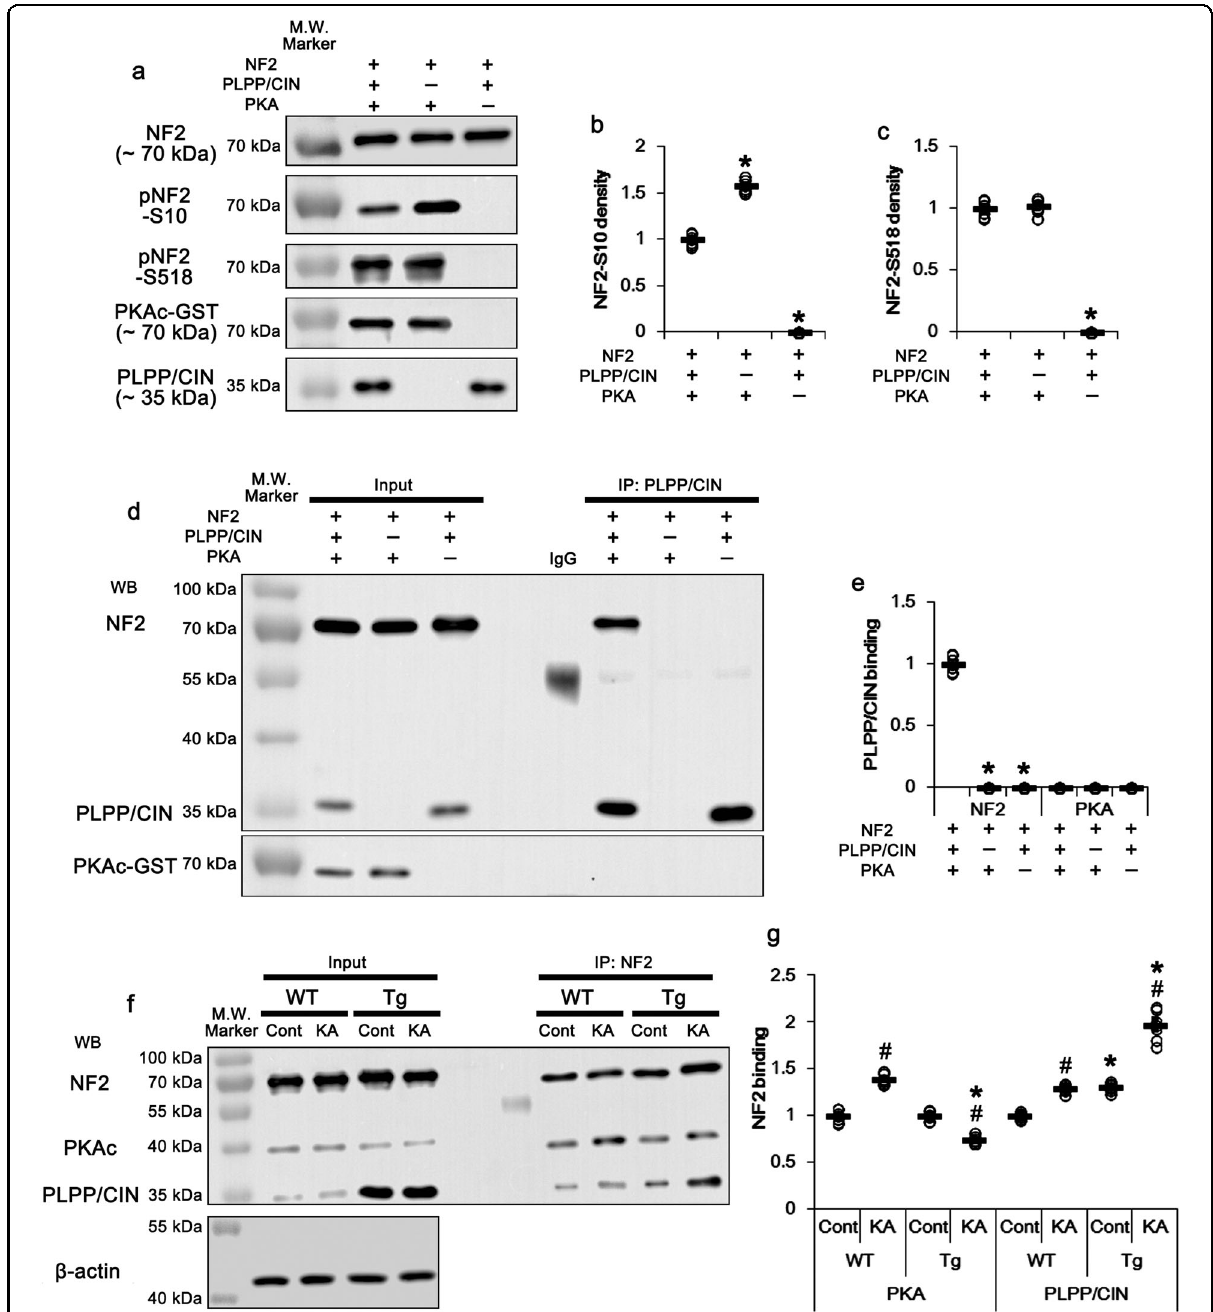
Fig. 1 PLPP/CIN-mediated NF2 dephosphorylation. a – e In vitro assay using recombinant proteins. a Representative western blot data demonstrating PLPP/CIN-mediated NF2 dephosphorylation. b, c Quanti fi cation of NF2-S10 ( b ) and -518 ( c ) phosphorylation levels based on western blot data. Open circles indicate each individual value. Horizontal bars indicate mean value ( *p < 0.05 vs. the presence of PLPP/CIN and PKAc; n = 7). d Representative co-immunoprecipitation data demonstrating PLPP/CIN-NF2 and -PKAc bindings. e Quanti fi cation of PLPP/CIN-NF2 and -PKAc bindings. Open circles indicate each individual value. Horizontal bars indicate mean value ( *p < 0.05 vs. the presence of PLPP/CIN and PKAc; n = 7). f , g Effects of KA on PLPP/CIN-NF2 and -PKAc bindings in WT and PLPP/CIN Tg mice in vivo. f Representative co-immunoprecipitation data demonstrating PLPP/CIN-PKAc and NF2 bindings. g Quanti fi cation of PLPP/CIN-PKAc and -NF2 bindings. Open circles indicate each individual value. Horizontal bars indicate mean value (* ,# p < 0.05 vs. WT and control animals, respectively; n =